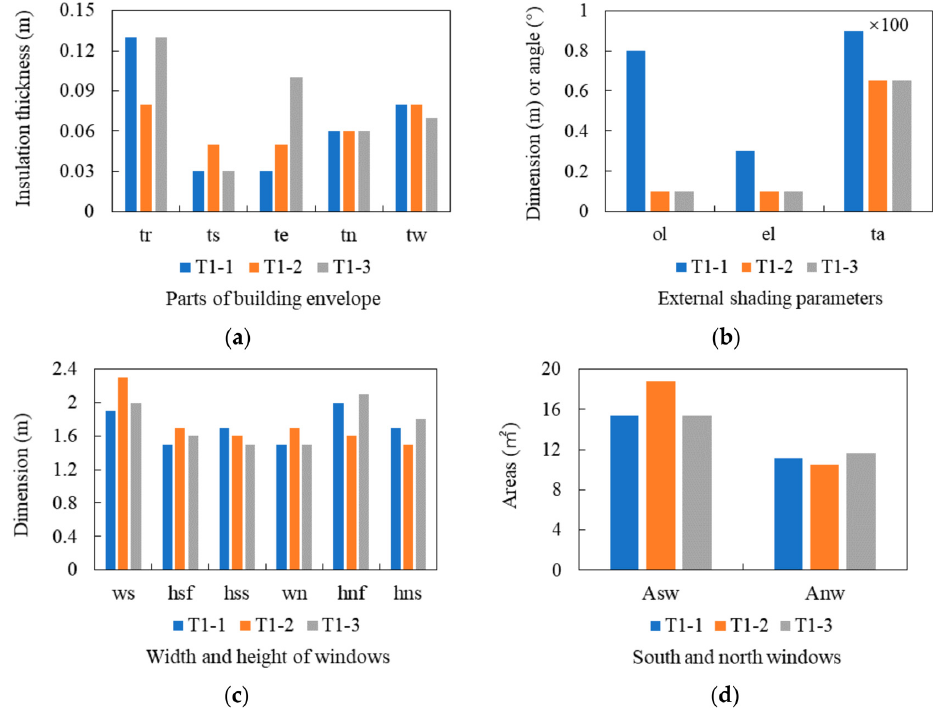
Figure 22. The design parameters under the three schemes: ( a ) thickness of insulation layer; ( b ) ex- ternal shading parameters; ( c ) width and height of windows; ( d ) size of south and north